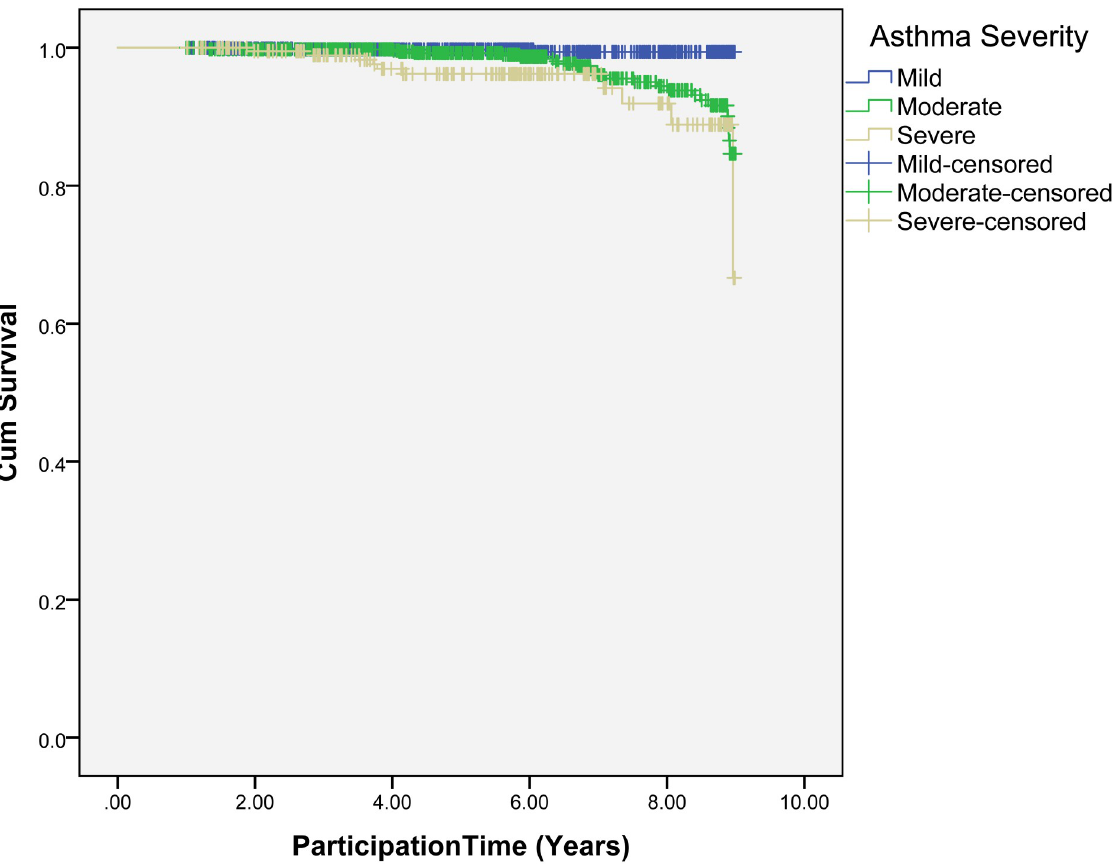
Fig 2. Speed of the occurrence of cancer among asthma patients associated with severity of asthma. https://doi.org/10.1371/journal.pone.0250430.g002 Fig 3 describes the average number of years for cancer diagnosis according to the top four cancers identified in Table 2. Lung cancer diagnosis was revealed to have the longest diagnosis period with an average of 36.6 years compared to prostate cancer with 16.5 years. This indicates that asthma might play a role in developing cancer through low level perturbation of the tissue.